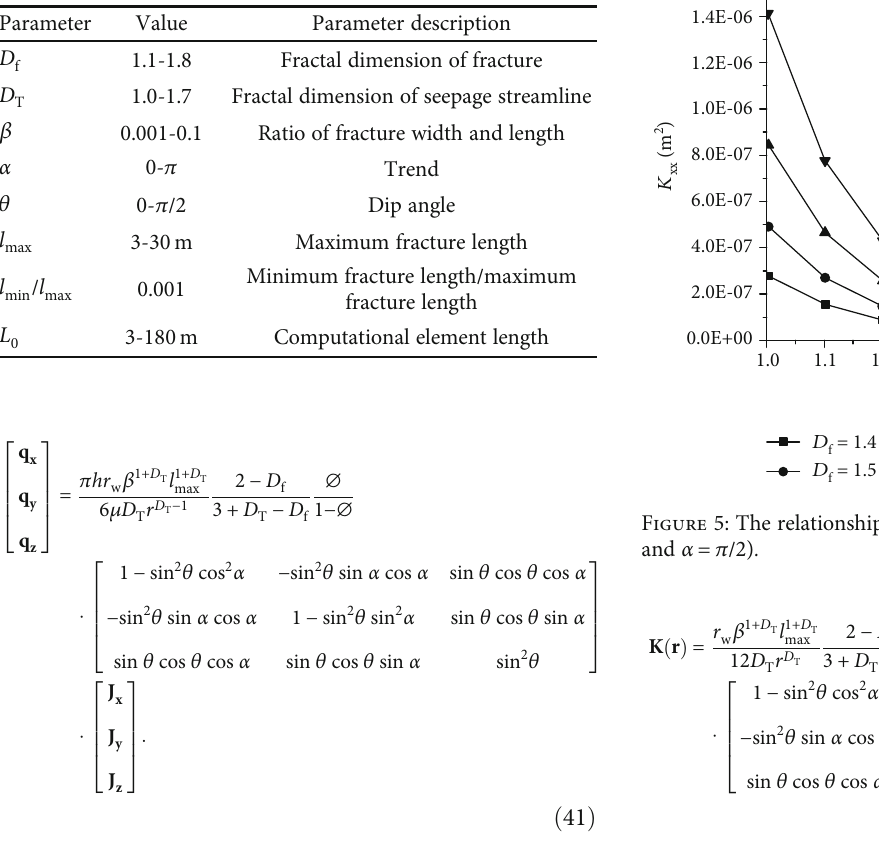
Table 1: List of calculation parameters.